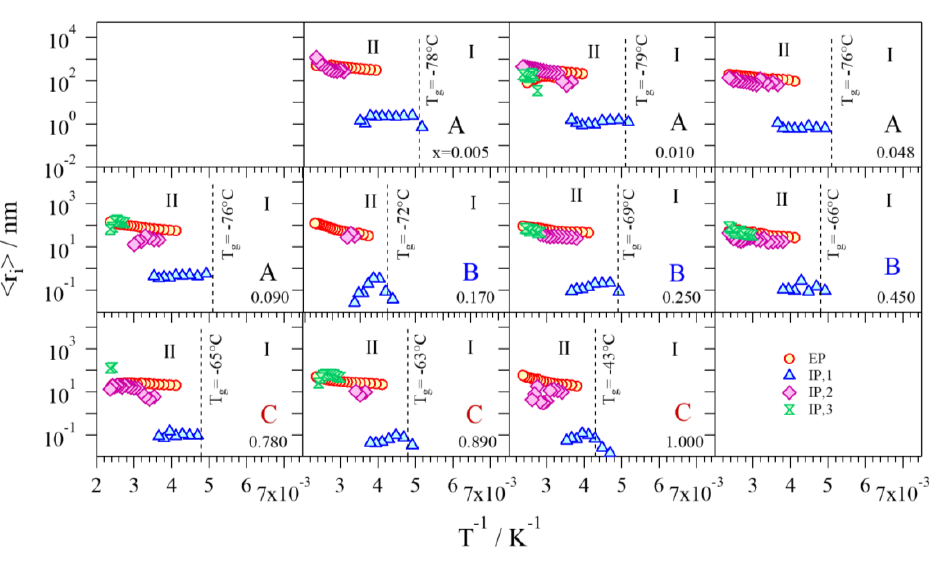
Figure 13. Average migration distance as a function of the temperature for σ EP , σ IP,1 , σ IP,2 , and σ IP,3 . It is observed that the migration distance increases as the temperature is raised. In Region I